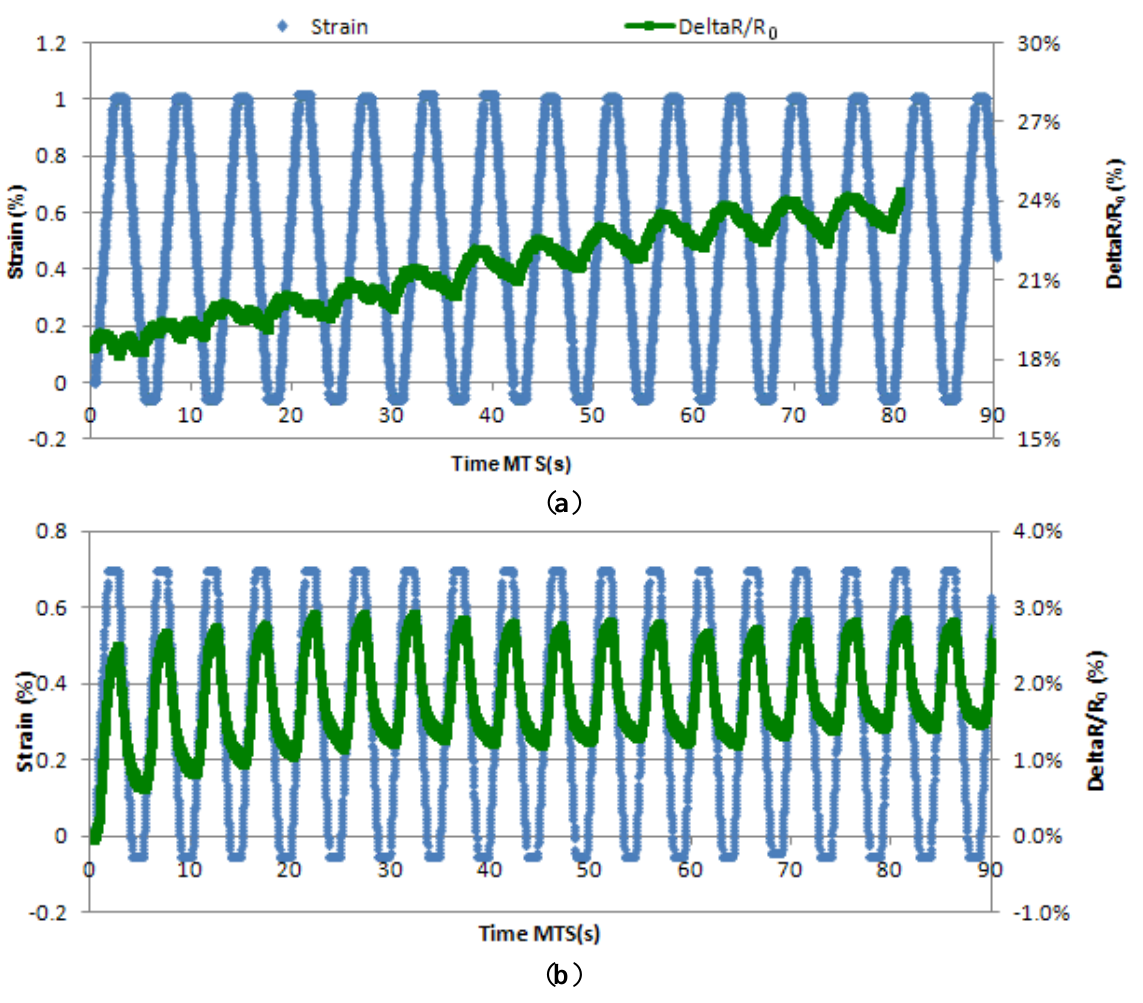
Figure 7. Strain and DeltaR/R vs. time between the cycles 0 and 15 of a sensor coated 0 with a 20.1 wt% dry CPP105D formulation. ( a ) is representative from the first series of sensors while ( b ) shows the improvement the second